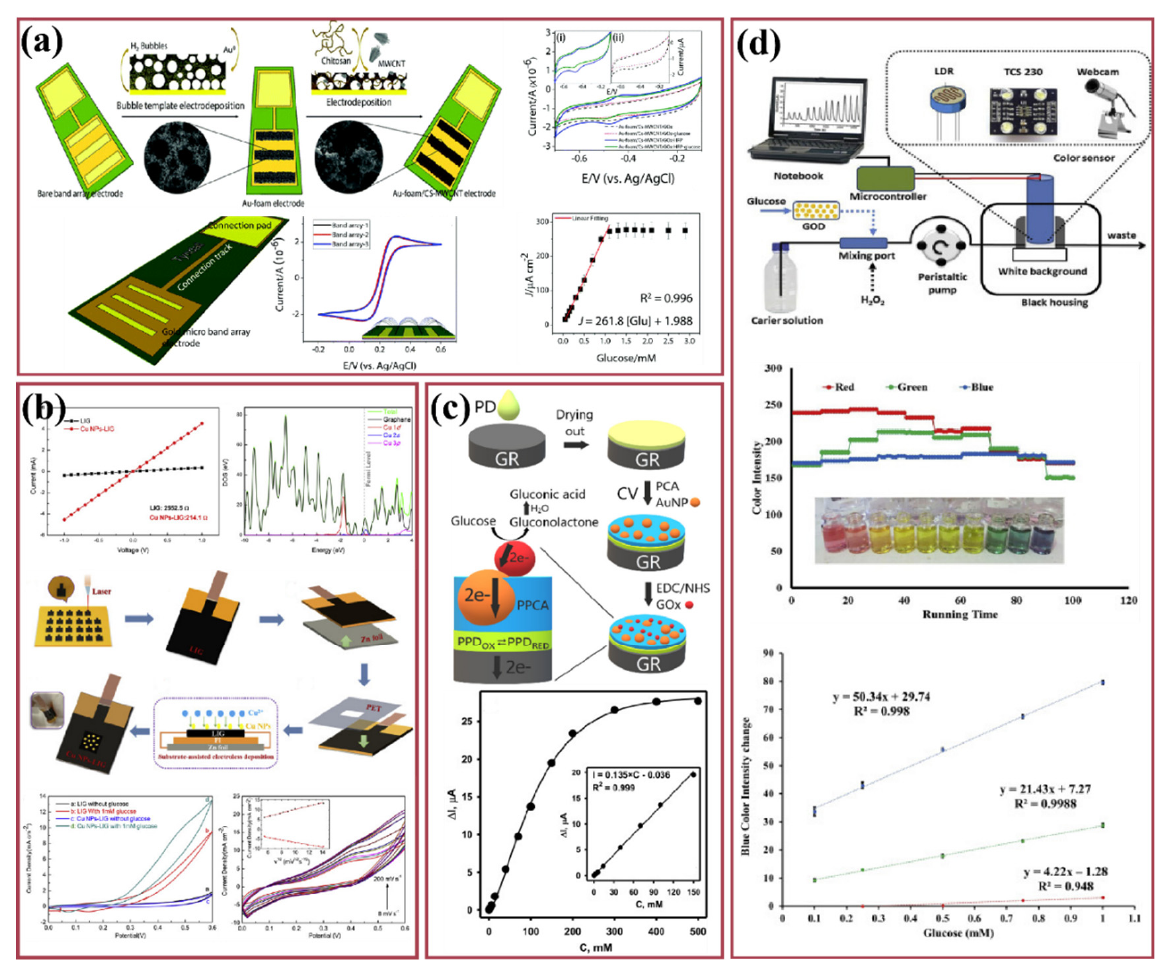
Figure 9. ( a ) Illustration of the 2-step electrochemical deposition process used to fabricate the Au- foam/CS–MWCNT electrode. (Reproduced with permission from Pemble et al., R. Soc. Chem., 2019 [157]. Copyright 2019, Royal Society Of Chemistry; O’reilly.) ( b ) Schematic illustration of fabrication process of the flexible Cu NPs-LIG sensor. (Reproduced with permission from Y. Zhang et al., Carbon, 2019 [164]. Copyright 2019, Elsevier Ltd.) ( c ) Working principle and operation of the GR/PPD/(AuNP)PPCA-GOx electrode biosensor. (Reproduced with permission from Minkstimiene et al., Microchem. J., vol.154, p. 104665, May 2020 [167]. Copyright 2020, Elsevier Ltd.) ( d ) The design of the color sensor in the flow analysis system. Color recognition device tested using a series solution (inset) at different pH values of 2.0 to 11.0 with the addition of universal pH solution. (Reproduced with permission from Fatoni et al., Sens. Bio-Sens. Res., pp. 30153–30159, 2020 [35]. Copyright 2020, authors under open access